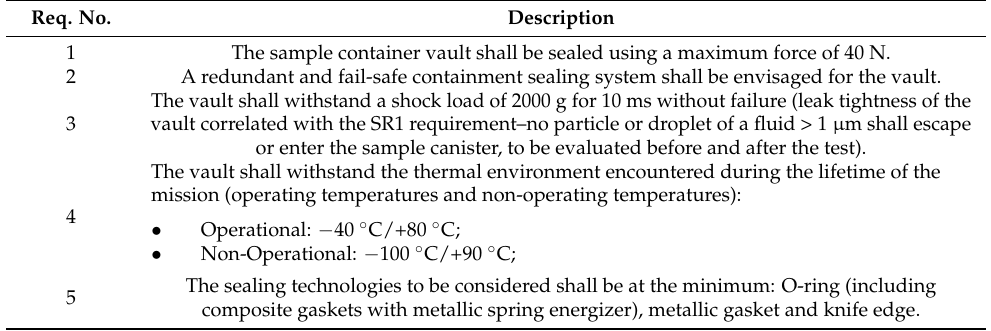
Table 1. Driving requirements considered for the development of the closing and sealing system. Req.